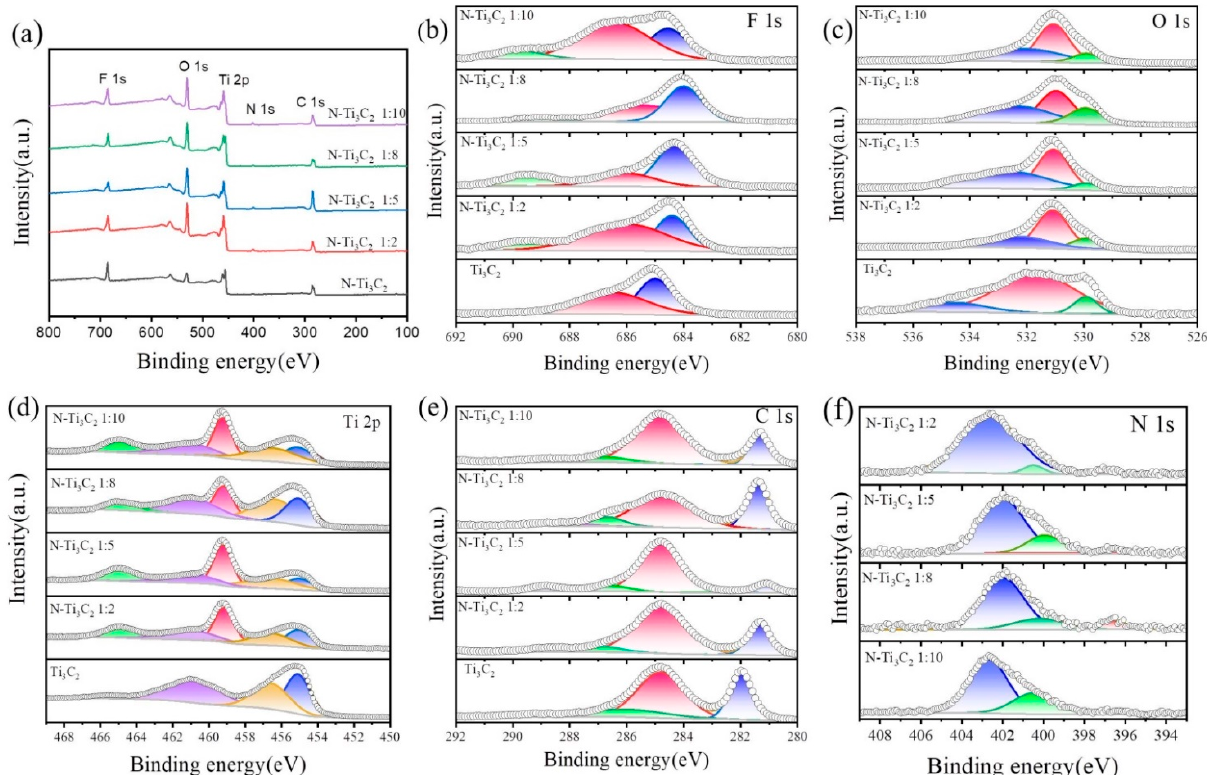
Figure 5. XPS spectra of the samples: ( a ) measurement scan, ( b ) F 1s, ( c ) O 1s, ( d ) Ti 2p, ( e ) C 1s, ( f ) N 1s.